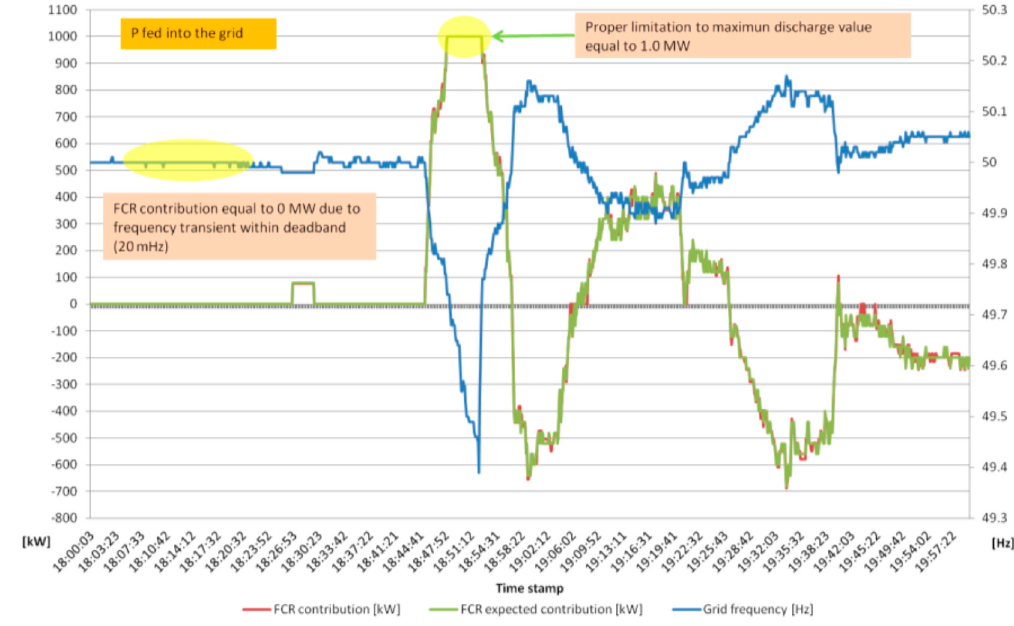
Figure 11. EESS GIG, total P output versus a real frequency transient (FCR contribution).